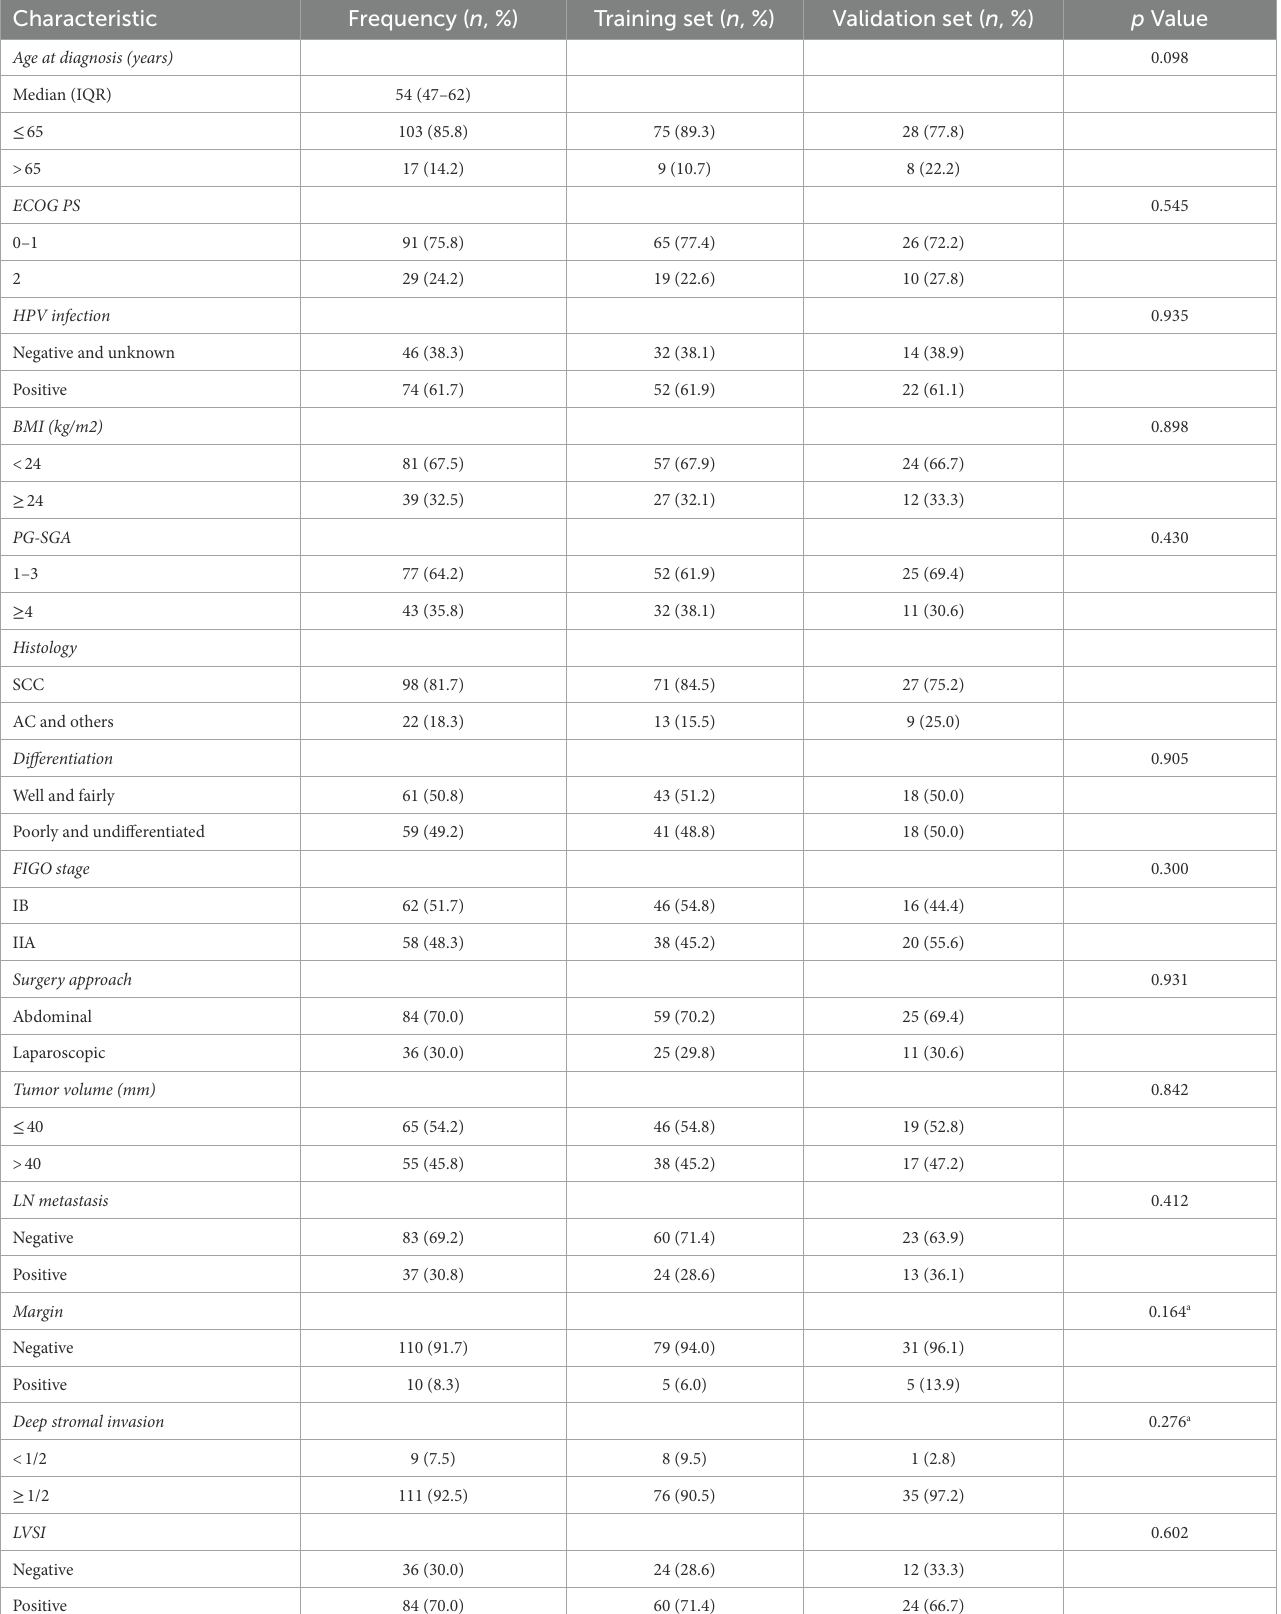
TABLE 1 Baseline characteristics of 120 patients with FIGO stage IB1-IIA2 CC who underwent postoperative RT/CRT.